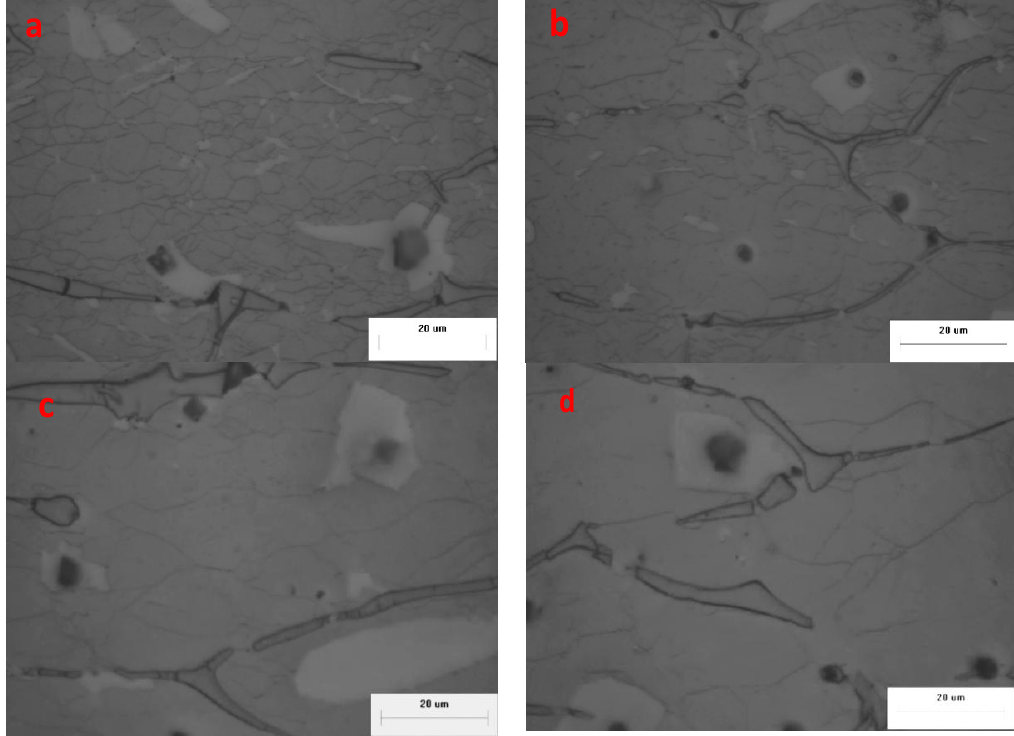
Figure 8. Optical microstructure of the material deformed at a strain of 0.4 and ( a ) 250 °C, 1 s − 1 ; ( b ) 250 °C, 0.1 s − 1 ; ( c )250 °C, 0.01 s − 1 ; ( d )250 °C, 0.001 s − 1 .